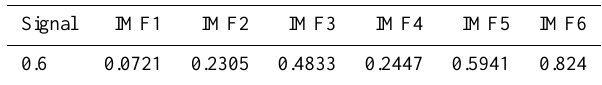
Table 2. Correlation coefficients( r) of IMFs between 1 14 C and 10 Be. Signal IMF1 IMF2